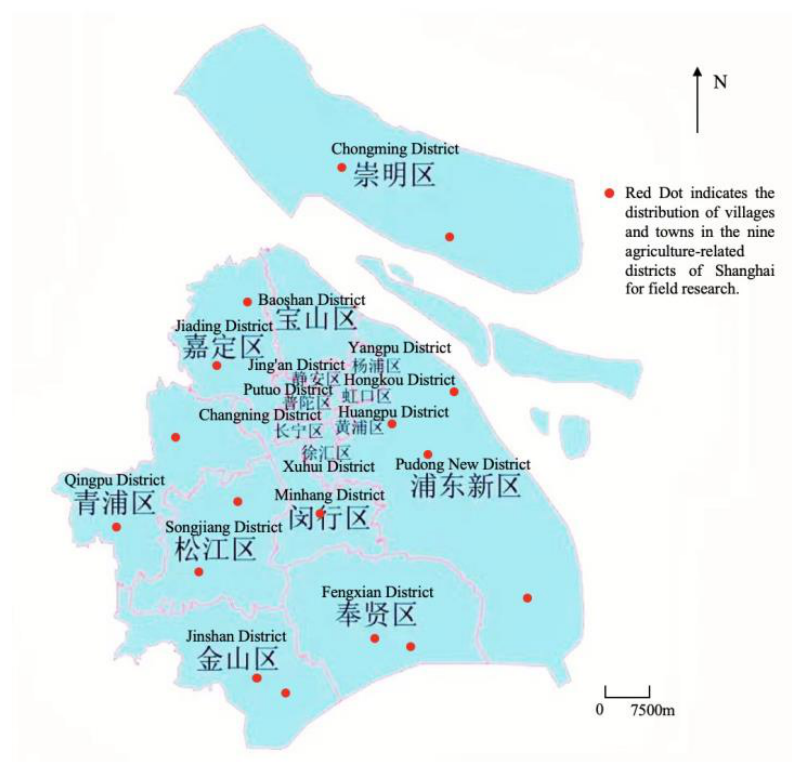
Figure 2. Map of survey sample sites.